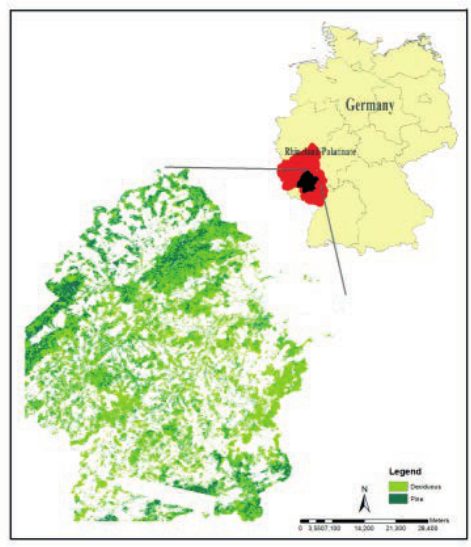
Fig. 1 Location and forest distribution of Nahe